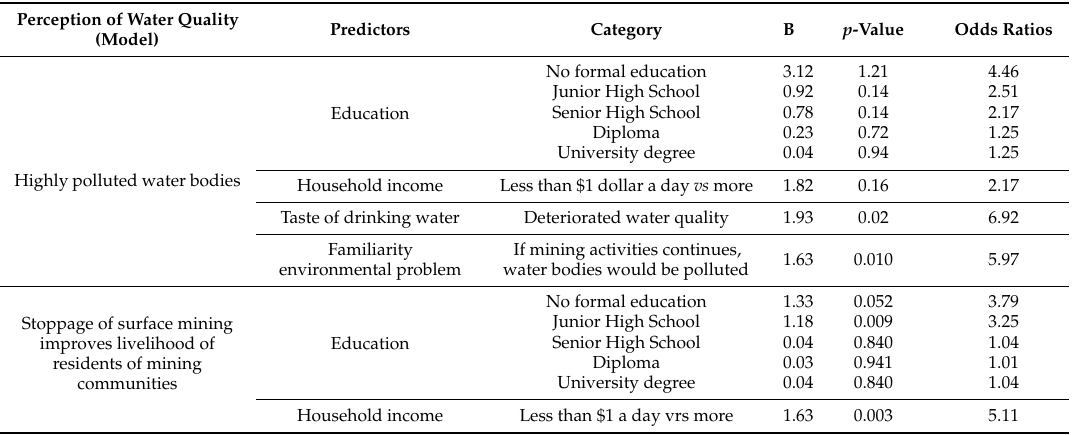
Table 6. Results of the logistic regression